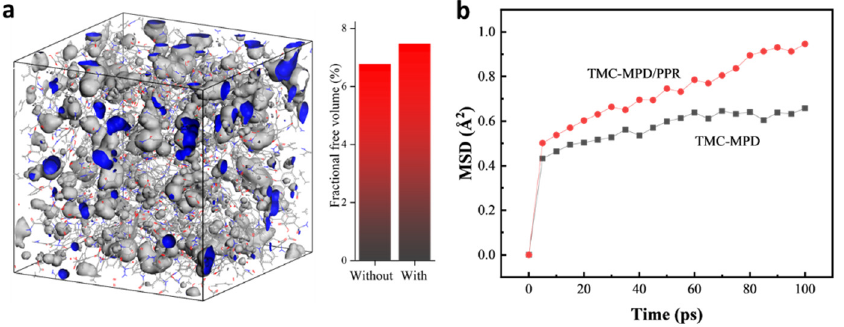
Figure 7. ( a ) Micro-properties of polyamide analyzed by molecular simulation; three-dimensional view of the free volume in the molecular model of polyamide synthesized by the reaction of TMC, MPD, and PPR; the probe radius is 1.4 Å; the outside surface of free volume region is shown in gray, and the interior of free volume is shown in blue; the right histogram shows the comparison of FFVs of polyamide models constructed with or without PPR; ( b ) mean square displacement (MSD) of polymer chains versus simulation